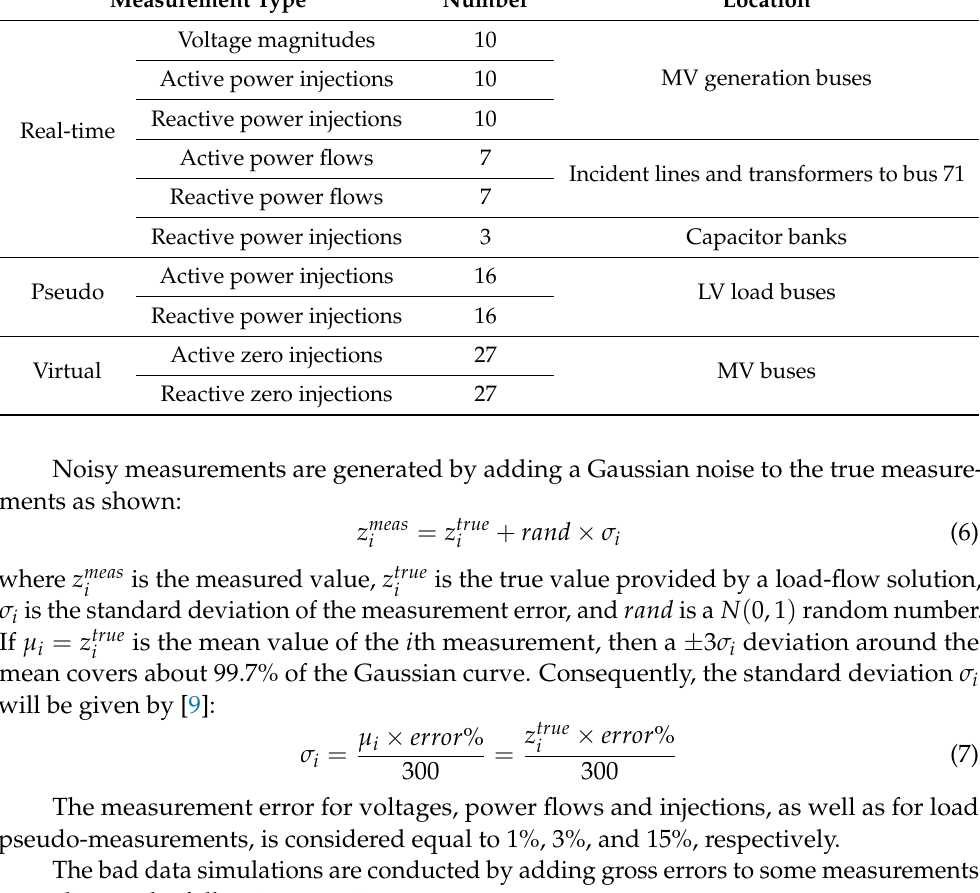
Table 3. Measurement type, number, and location for the 55-bus test system. Measurement